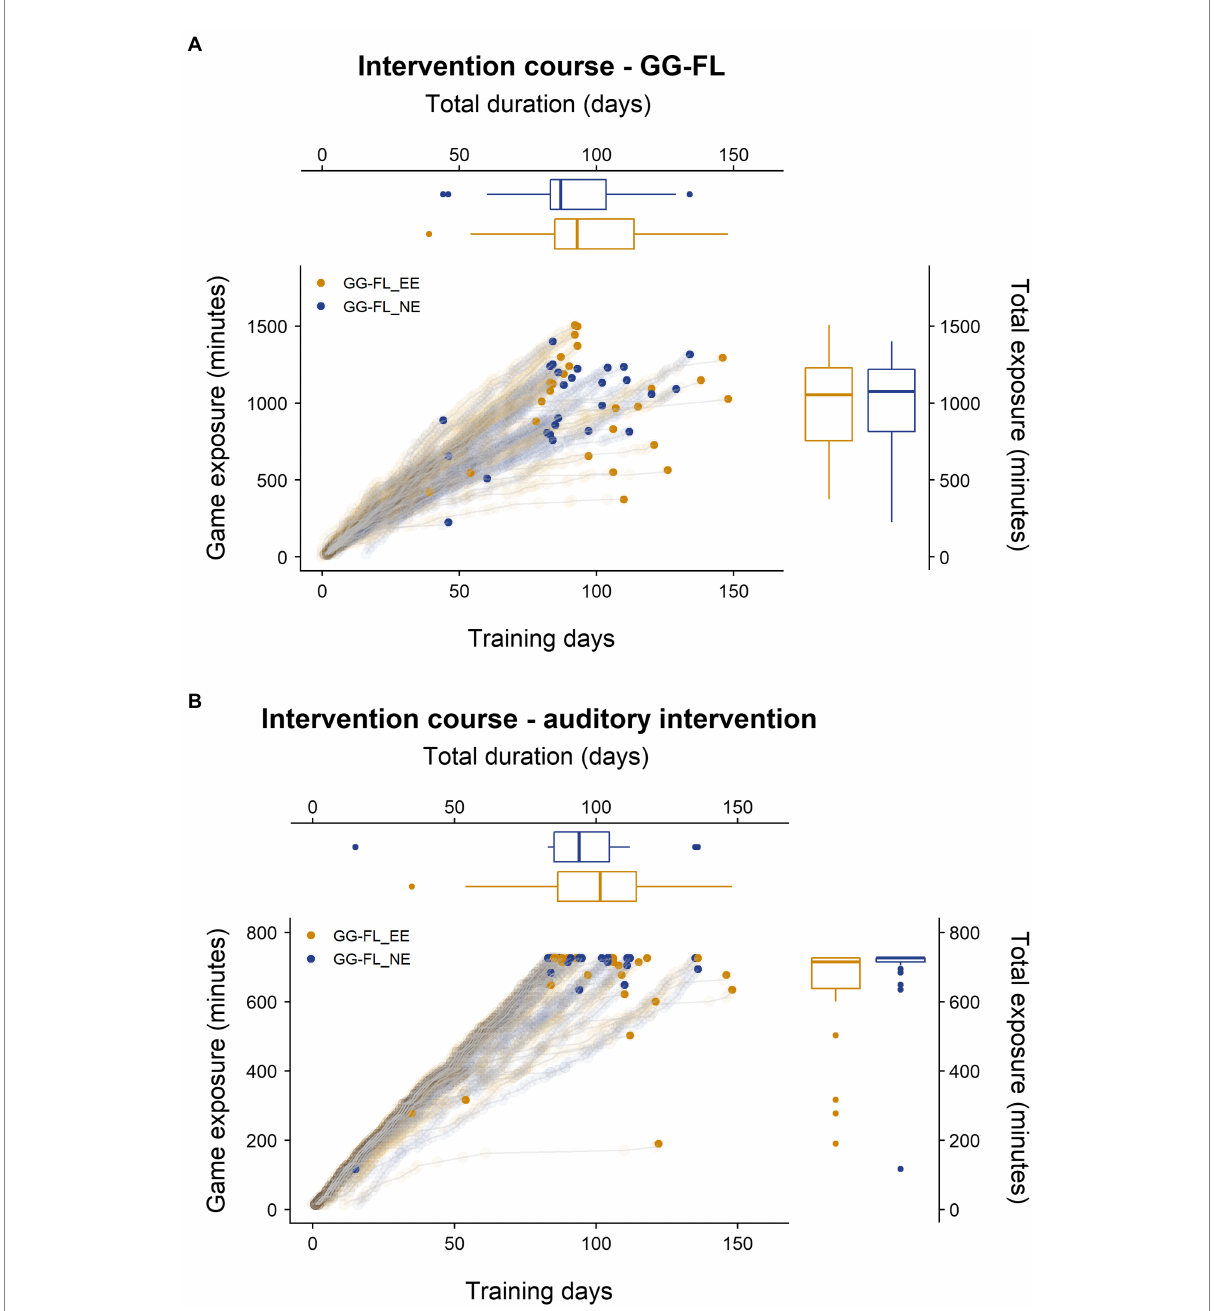
FIGURE 3 Individual intervention trajectories and the distribution of the final intervention exposure (minutes) and final training duration (days). (A) Trajectories of GG-FL. (B) Trajectories of the auditory intervention. Bold dots represent individuals’ final game exposures and final training durations. GG-FL, GraphoGame Flemish; GG-FL_EE, GraphoGame Flemish + envelope enhancement group; and GG-FL_NE, GraphoGame Flemish + non- enhanced